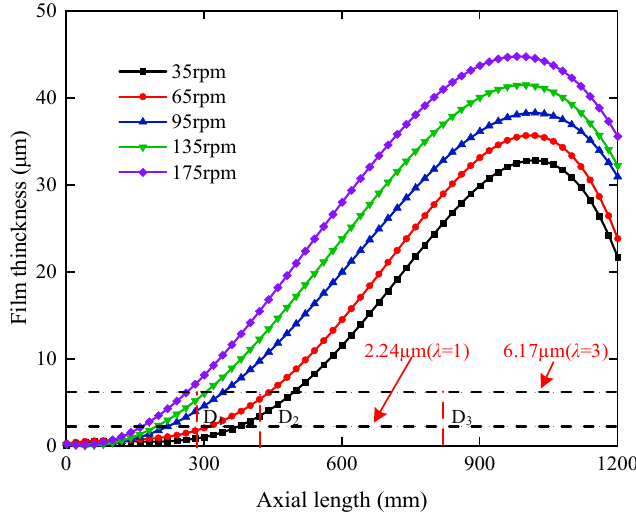
Figure 14. Comparison of shaft ‐ bending curves from FE simulation and least square fitting .